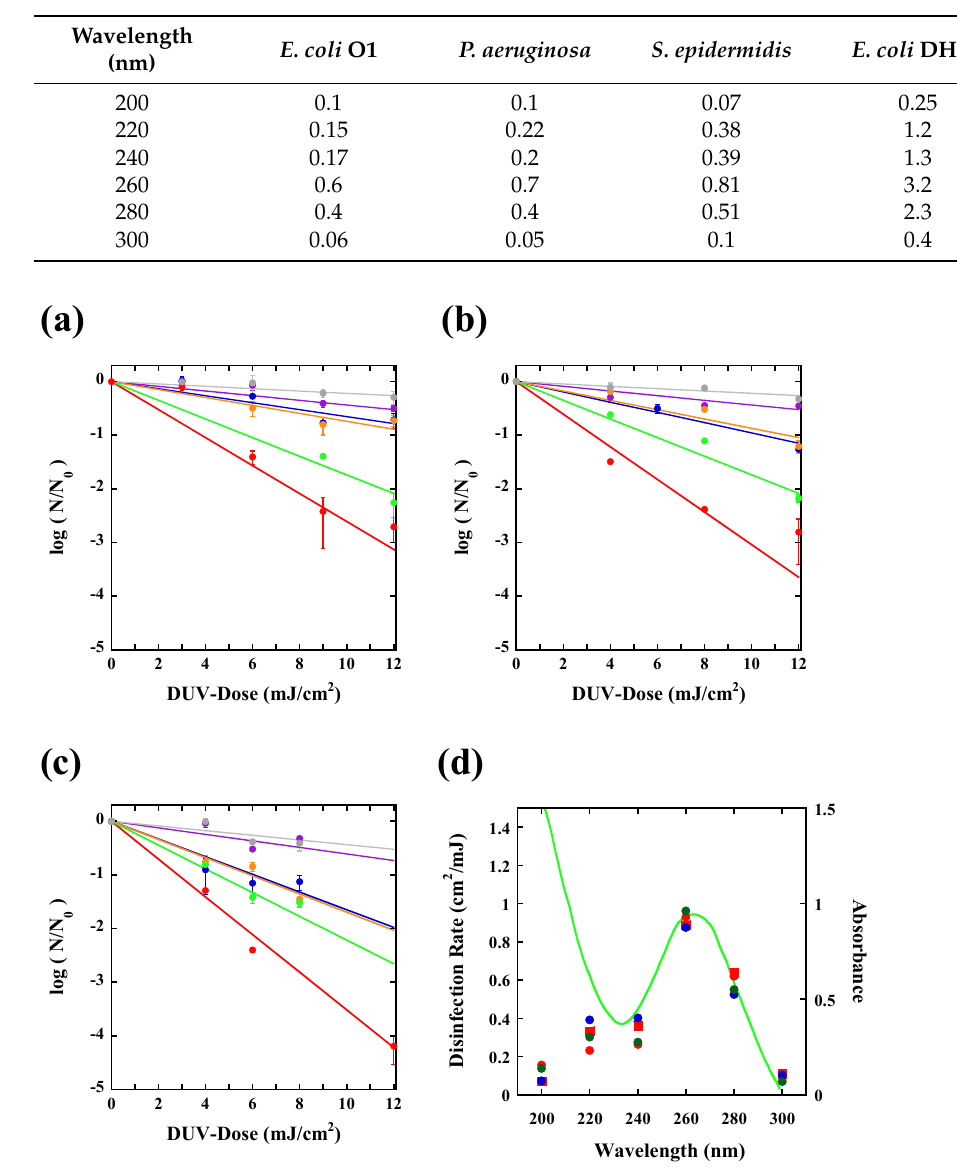
Figure 3. DUV dose response of ( a ) E. coli O1, ( b ) P. aeruginosa , and ( c ) S. epidermidis . The purple circles were obtained by 200 nm irradiation, the blue circles were obtained by 220 nm irradiation, the orange circles were obtained by 240 nm irradiation, the red circles were obtained by 260 nm irradiation, the green circles were obtained by 280 nm irradiation, and the gray circles were obtained by 300 nm irradiation. ( d ) Correlation graph between the inactivation rate constants given in Table 1 and the absorption curve of DNA, where the rate constant of E. coli O1 was multiplied by 1.55 (red circles), the value of P. aeruginosa was multiplied by 1.37 (green circles), the value of S. epidermidis was multiplied by 1.1 (blue circles), and the value of E. coli DH5 α was multiplied by 0.275 (red squares) to correlate the absorbance with these rate constants.